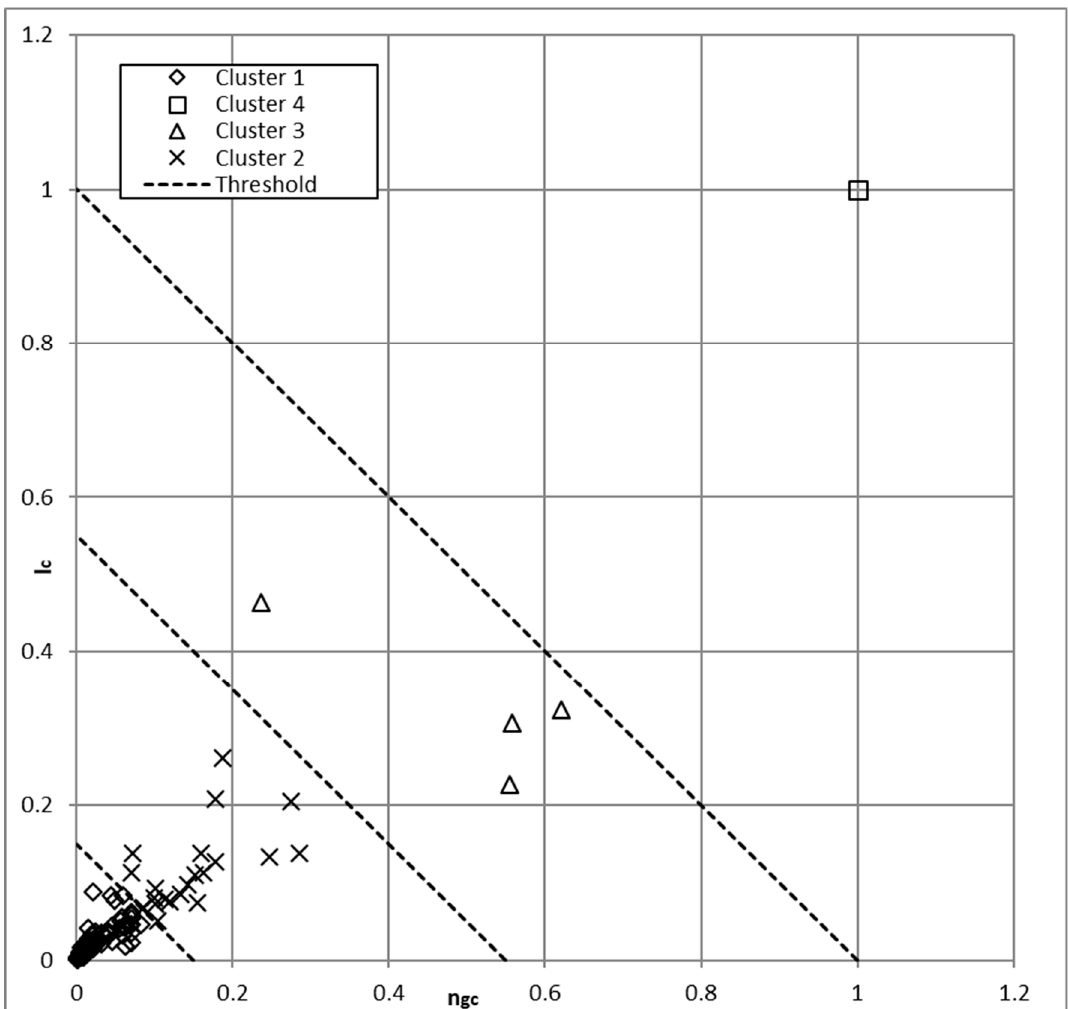
Figure 7. Clustering obtained with the k-means algorithm considering the attributes l c and n gc .